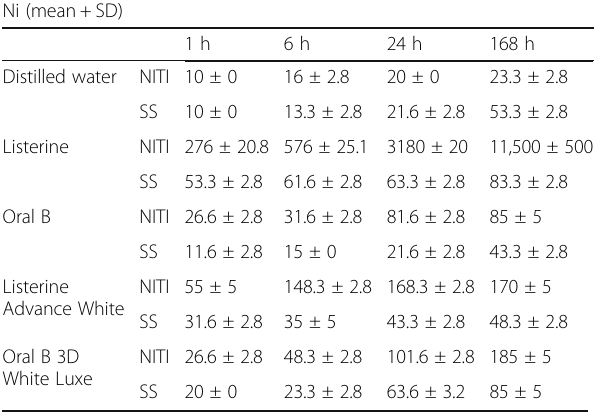
Table 6 Release of nickel ions from NiTi and SS wires at various time-points